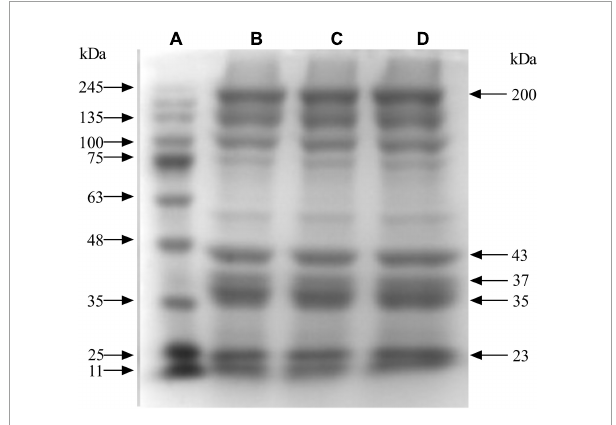
FIGURE1 MP electrophoresis results. A is Marker; B, C, and D are